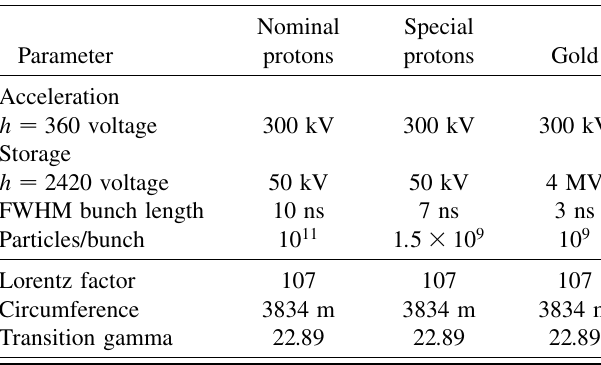
FIG. 6. Initial and final wcm